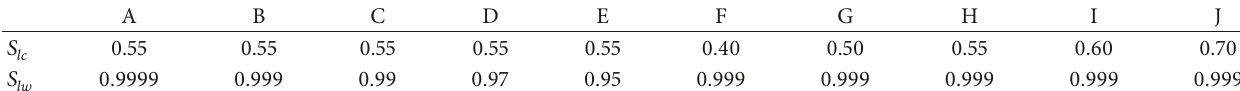
Table 3: The values of parameters 𝑆 𝑙𝑤 and 𝑆 𝑙𝑐 .